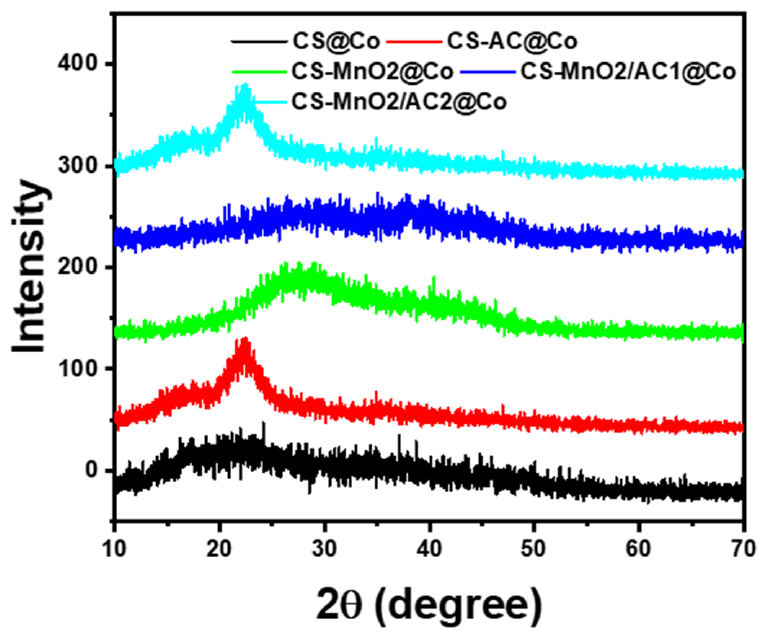
Figure 2. XRD spectrum of the synthesized catalysts.